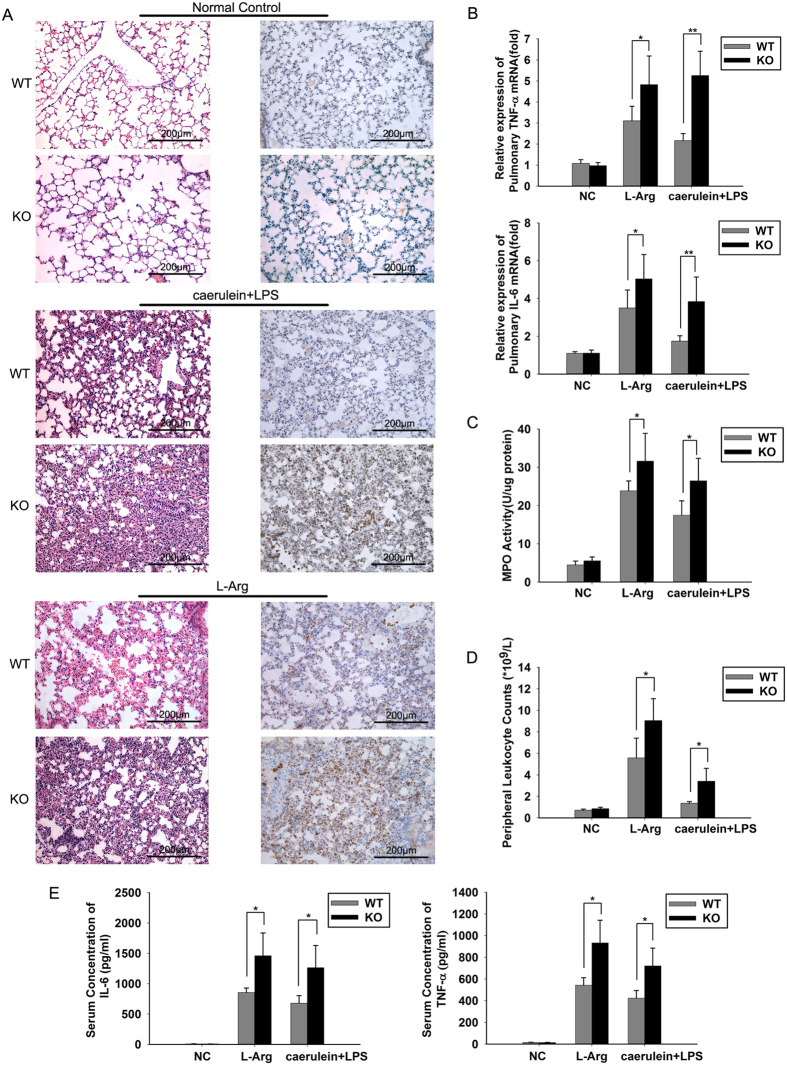
JAM-C deficiency aggravated lung injuries and systemic inflammation in experimental pancreatitis.(A) Representative micrographs show that JAM-C-deficient mice experienced more severe lung injuries than their wild-type littermates. Left row: H&E sections; Right row: immunohistochemical analysis of neutrophil infiltration by Ly-6G antibody. (B) Quantitative reverse transcription PCR demonstrated increased mRNA levels of IL-6 and TNF-α in the lung tissues of JAM-C-deficient mice (*p < 0.05, **p < 0.01). (C) Pulmonary myeloperoxidase (MPO) activity showed that JAM-C-deficient mice exhibited more severe lung damage than wild-type animals (*p < 0.05). (D) Total counts of circulating leukocytes showed increased numbers of leukocytes in JAM-C-deficient mice compared with their wild-type littermates in murine acute pancreatitis (*p < 0.01). (E) The serum levels of IL-6 and TNF-a were increased in JAM-C-deficient mice as measured by ELISA (*p < 0.05). NC: normal control, WT: wild-type mice, KO: JAM-C knockout mice. n = 4~11. Original magnification ×200. Mice were sacrificed 12 h after the first caerulein injection or 3 d after the first L-arginine (L-Arg) injection.